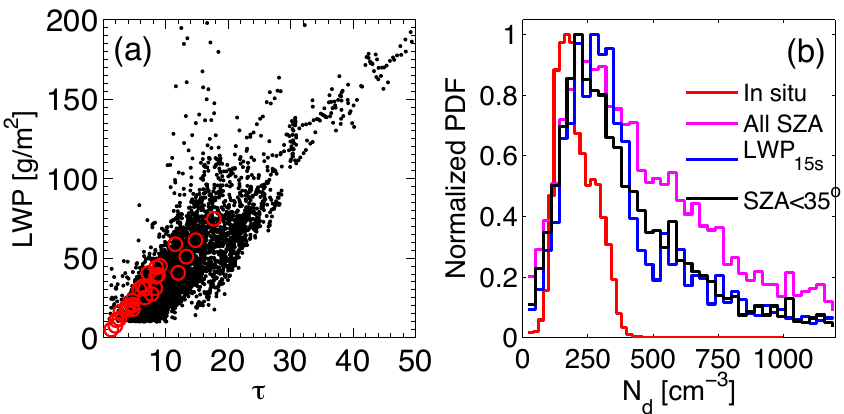
Figure 6: a) LWP versus τ . Black dots represent the remote sensed values, and the red 975 Fig. 6. (a) LWP versus τ . Black dots represent the remote sensed values, and the red circles are the values derived from the cloud probes. (b) Normalized probability density function (PDF) for the remote sensing-based N d (magenta, black, and blue lines, Eq. (9)) and the in situ N d circles are the values derived from the cloud probes. b) Normalized probability density 976 obtained during in-cloud legs (red line). The remote sensing-based N d was estimated from samples with LWP > 20gm − 2 (magenta line) and solar zenith angle smaller than 35 ◦ (black line). Blue line corresponds to N d calculated with the 15-s averaged LWP. Remote sensing-based function (PDF) for the remote sensing-based N (magenta, black, and blue lines, eq. (9)) 977 d N d retrievals were calculated for τ > 2, LWP > 20gm − 2 , overcast at 1.4km scale, and column-maximum reflectivity < − and the in-situ N obtained during in-cloud legs (red line). The remote sensing-based N 978 d d was estimated from samples with LWP>20 gm -2 (magenta line) and solar zenith angle 979 smaller than 35˚ (black line). Blue line corresponds to N calculated with the 15-s 980 d averaged LWP. Remote sensing-based N retrievals were calculated for τ >2, LWP>20 981 d gm -2 , overcast at 1.4 km scale, and column-maximum reflectivity <-17 dBZ. 982